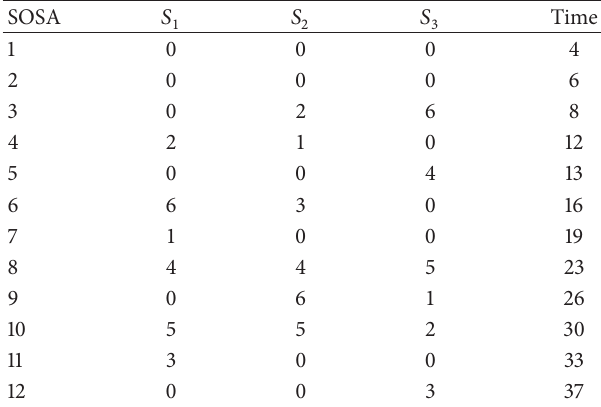
Table 3: Types of sequence of